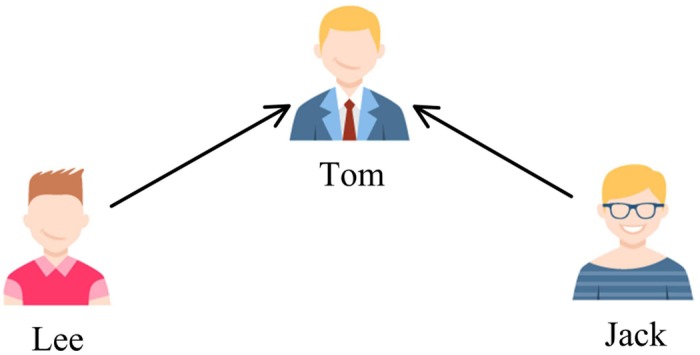
Different relation types in Twitter: The second case.